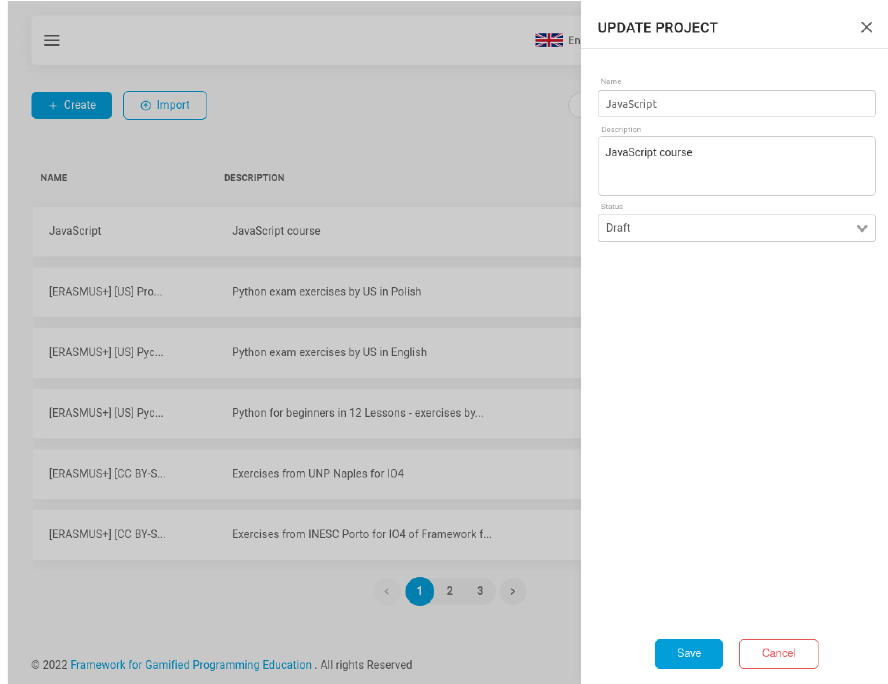
Figure 4. Screenshot of FGPE AuthorKit while editing a